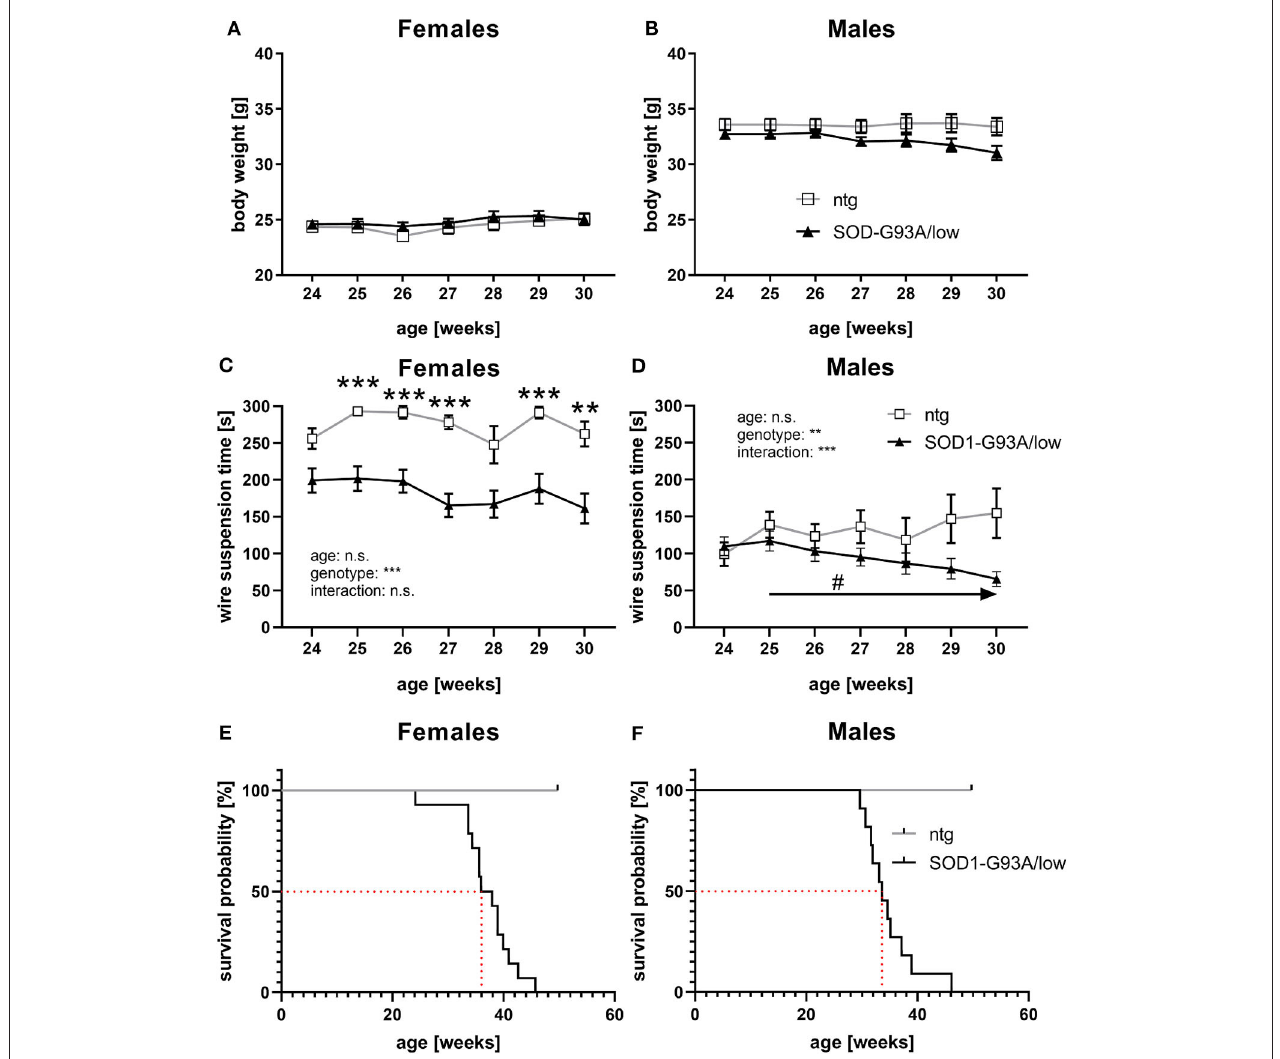
FIGURE 5 | Body weight, muscle strength, and survival rate of SOD1-G93A/low mice. (A,B) The body weight of female (A) and male (B) SOD1-G93A/low mice was evaluated weekly from 24 to 30 weeks. Mean ± SEM. Two-way ANOVA with Tukey’s and Sidak’s multiple comparison post hoc test. All comparisons were not significant. (C,D) Mean latency to fall off the wire grid in the wire suspension test of 24–30 weeks old female (C) and male (D) SOD1-G93A/low mice compared to ntg littermates. Mean ± SEM. Mixed-effects analysis with Tukey’s and Sidak’s multiple comparison post hoc test; # p < 0.05, ** p < 0.01, *** p < 0.001. *Differences between genotypes; # differences between age groups. (E,F) Kaplan-Meier curve showing survival probability of female (E) and male (F) SOD1-G93A/low mice. Median survival rates are marked with a red dotted line. Group size at start: SOD1-G93A/low: n = 39; ntg: n =